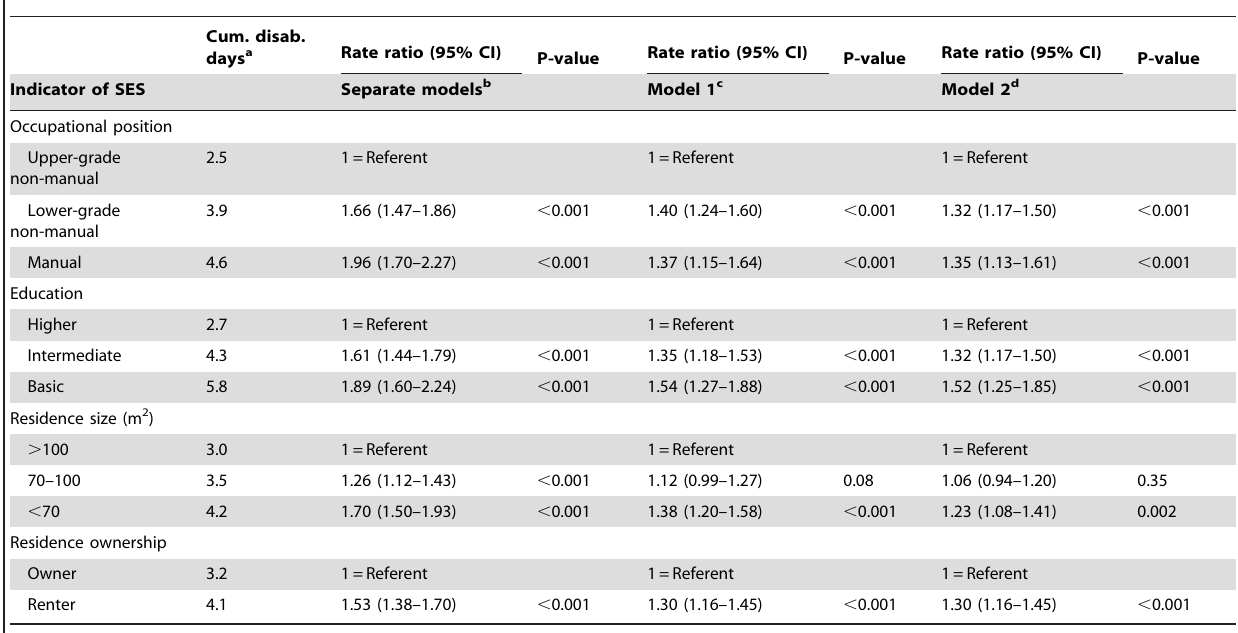
Table 2. Associations between indicators of socioeconomic status (SES) work disability days due to depression in 2005–2011.